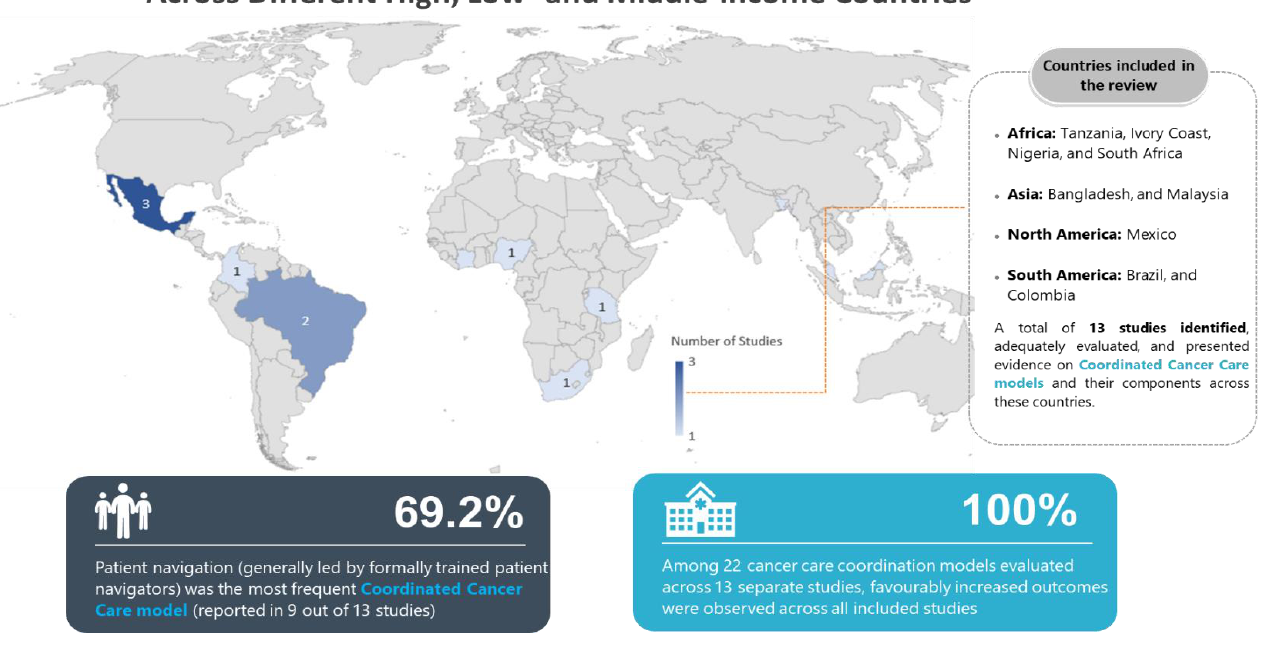
Figure 2. The world map presenting countries included in the review. Countries are listed according to the region and in alphabetical order (figure generated by the first author using PowerPoint).